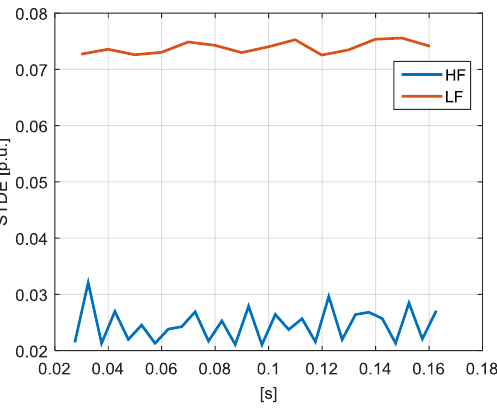
Figure 15. Case study 2: STDE at low-frequency (0 ÷ 2 kHz, red line) and at high-frequency (2 ÷ 150 kHz, blue line) obtained by the late approach.